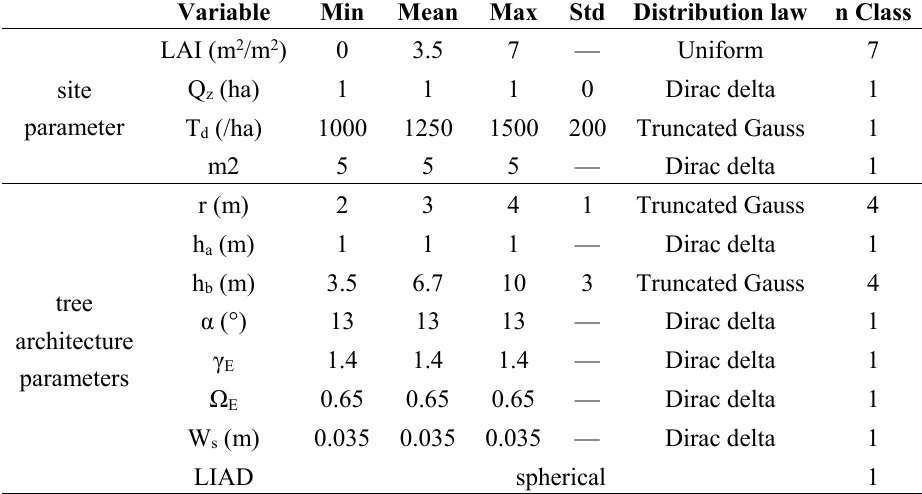
Table 3. Distribution of the canopy structure parameters of the four-scale model used to generate the training dataset.